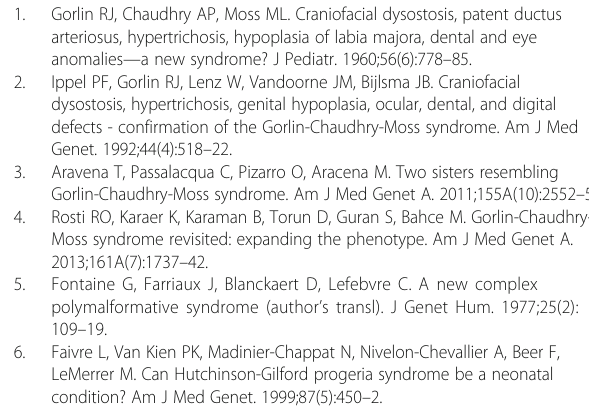
Abbreviations Arg: Arginine; Cys: Cysteine; FFS: Fontaine – Farriaux syndrome; FPS: Fontaine progeroid syndrome; GCMS: Gorlin – Chaudhry – Moss syndrome; GH: Growth hormone; His: Histidine; NA: Not applicable; NICU: Neonatal intensive care unit; NK: Not known; PLWS: Petty – Laxova – Wiedemann